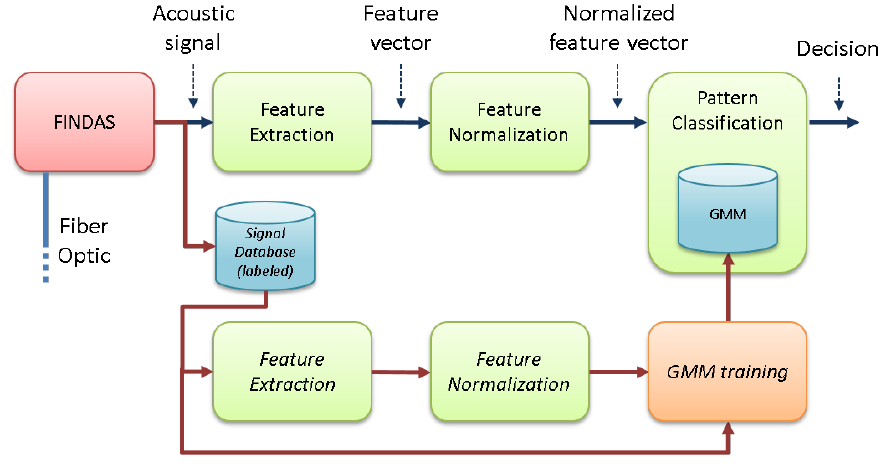
Figure 1. Baseline version of the system architecture